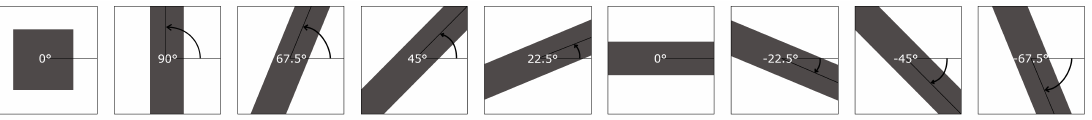
Figure 2. Windows with various orientations used in the stereo matching algorithm.